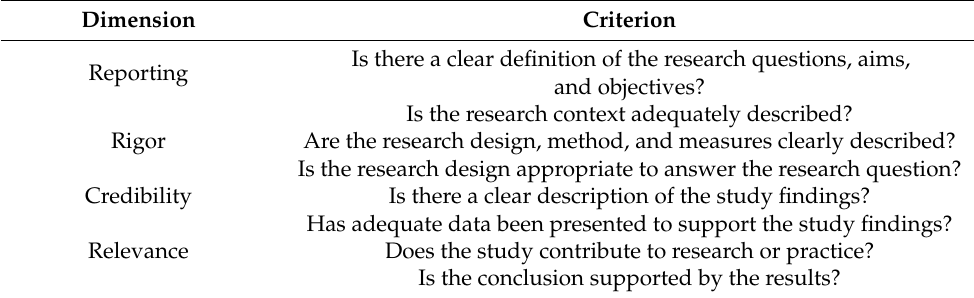
Table 2. Quality appraisal